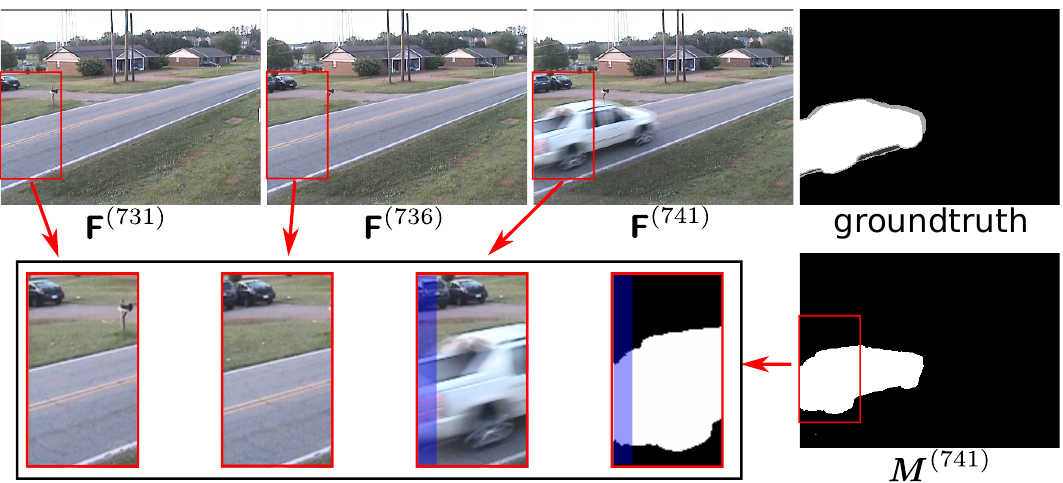
Figure 6. A sample when there is no matched region from the reference frames for the boundary of the current frame. In detail, M ( 741 ) denotes the predicted final foreground mask for the current frame F ( 741 ) , with the reference previous frames F ( 736 ) and F ( 731 ) . The images in the bottom left corner are the enlarged version of the details in red boxes, respectively. The region covered by blue highlights the region without a